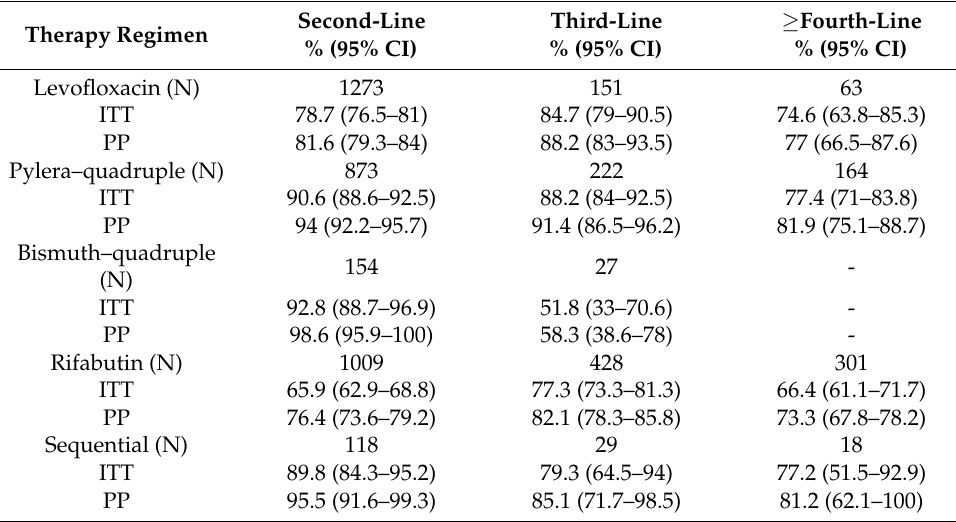
Table 1. Eradication rates at intention-to-treat (ITT) and per-protocol (PP)